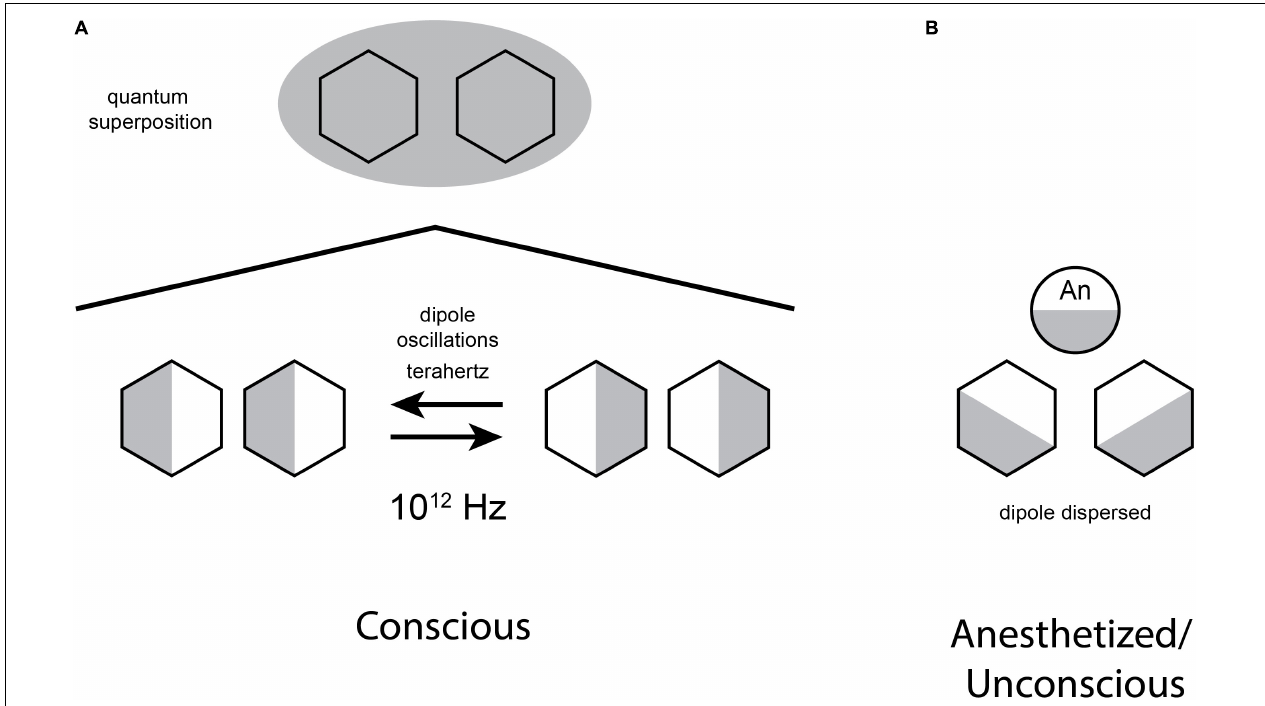
FIGURE 5 | (A) Oscillating benzene rings may exist in superposition of both dipole orientations, thus forming a potential quantum bit, or “qubit” as used in quantum computers, and for consciousness in the Orch OR theory. (B) Anesthetic gases bind in non-polar regions and form their own van der Waals “dipole dispersion” forces, preventing oscillation and superposition (concept similar to Hameroff, 2020).